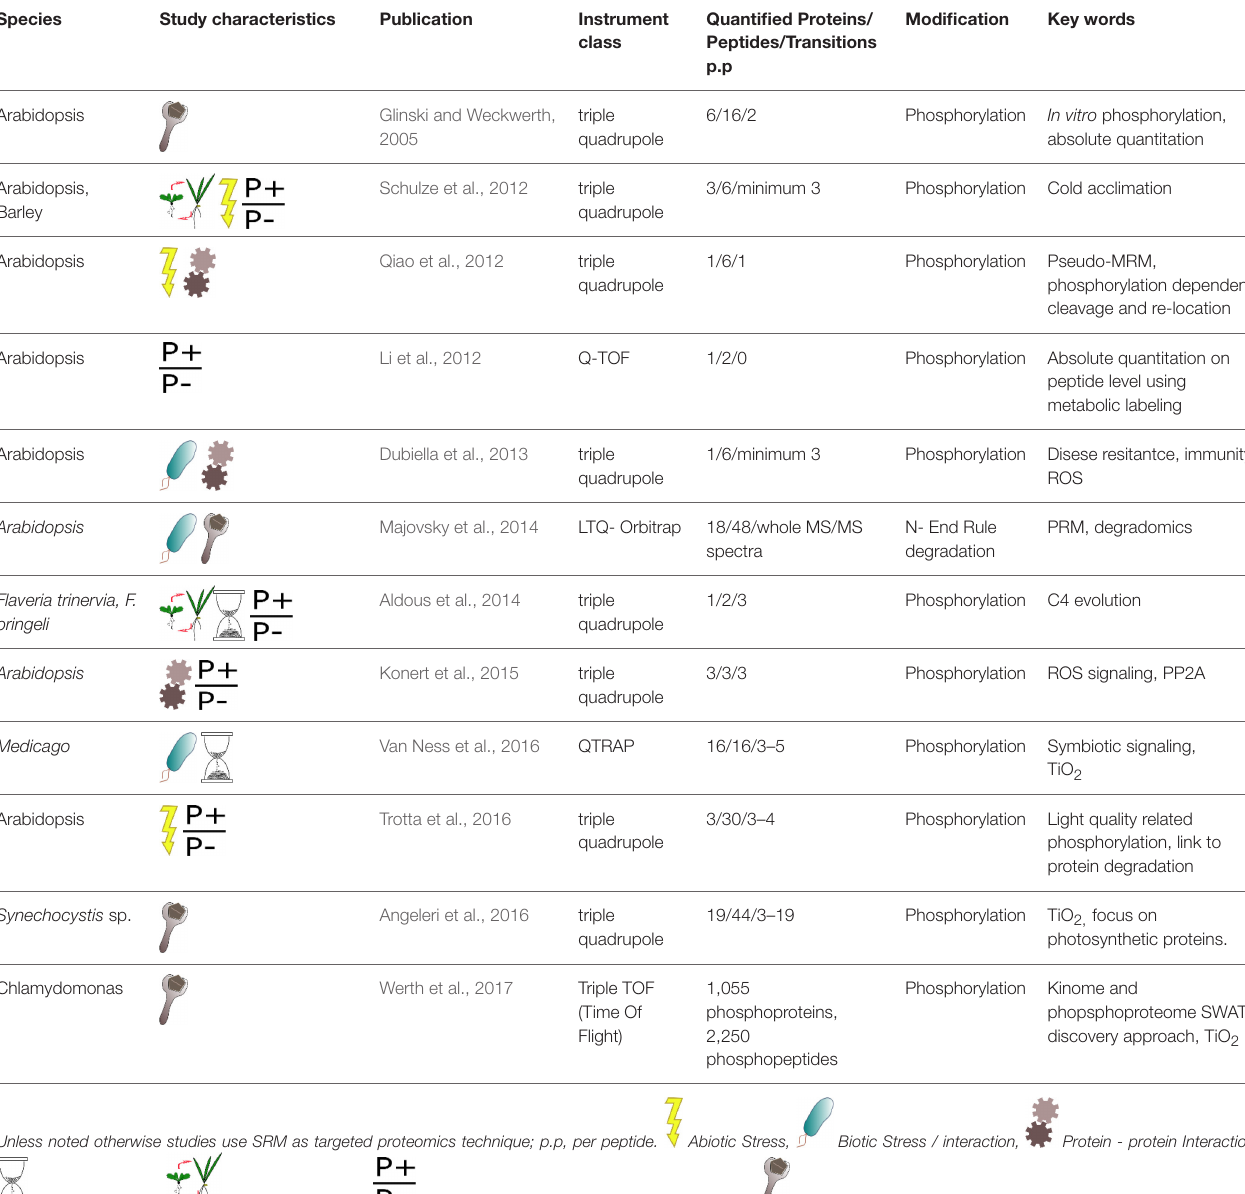
TABLE 1 | Overview of studies using targeted proteomics for the analysis of plant protein PTMs.